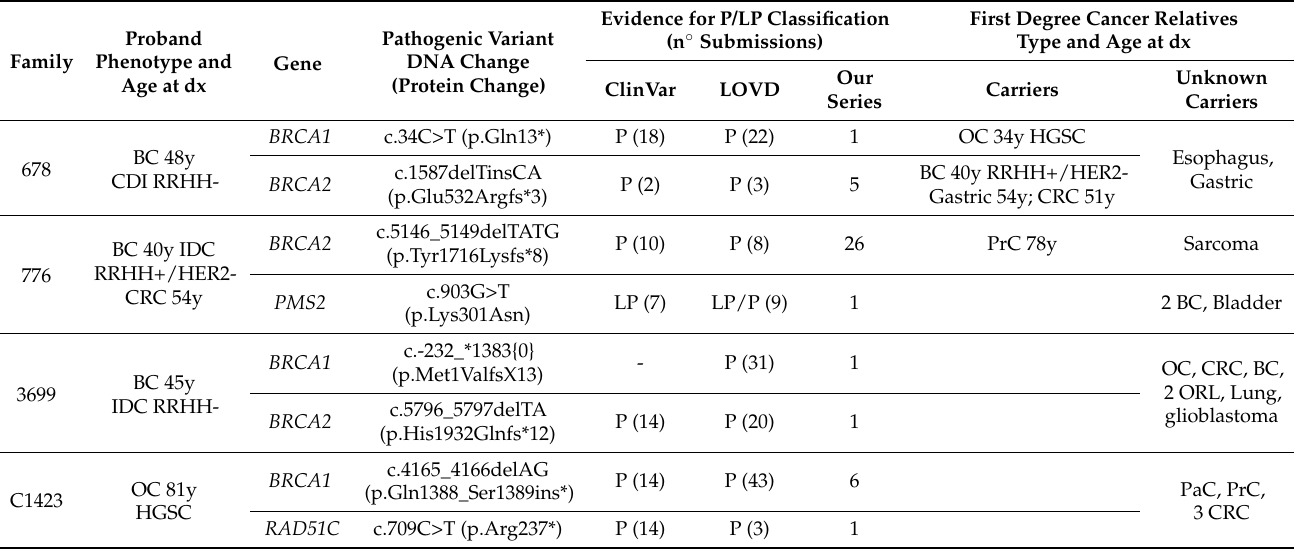
Table 1. Probands with two pathogenic/likely pathogenic